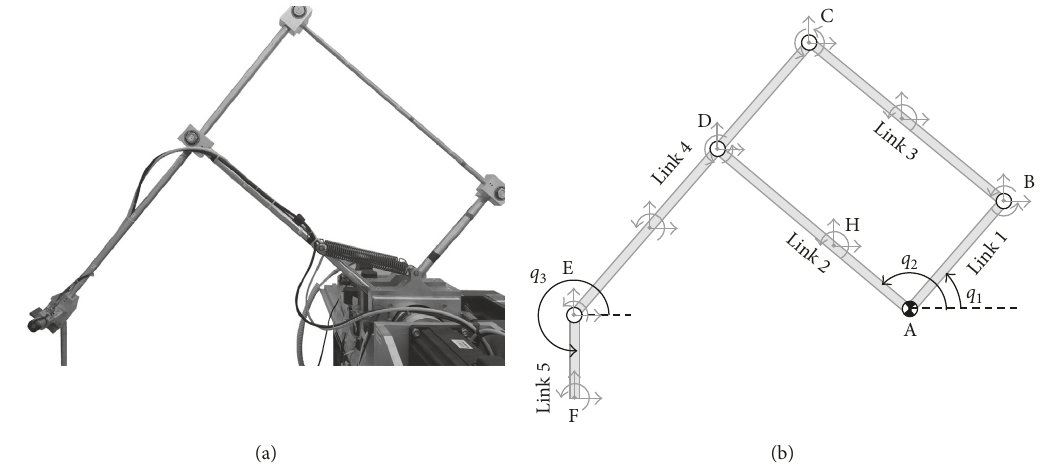
Figure 3: (a) Picture of the planar, three-dof manipulator and (b) its FE